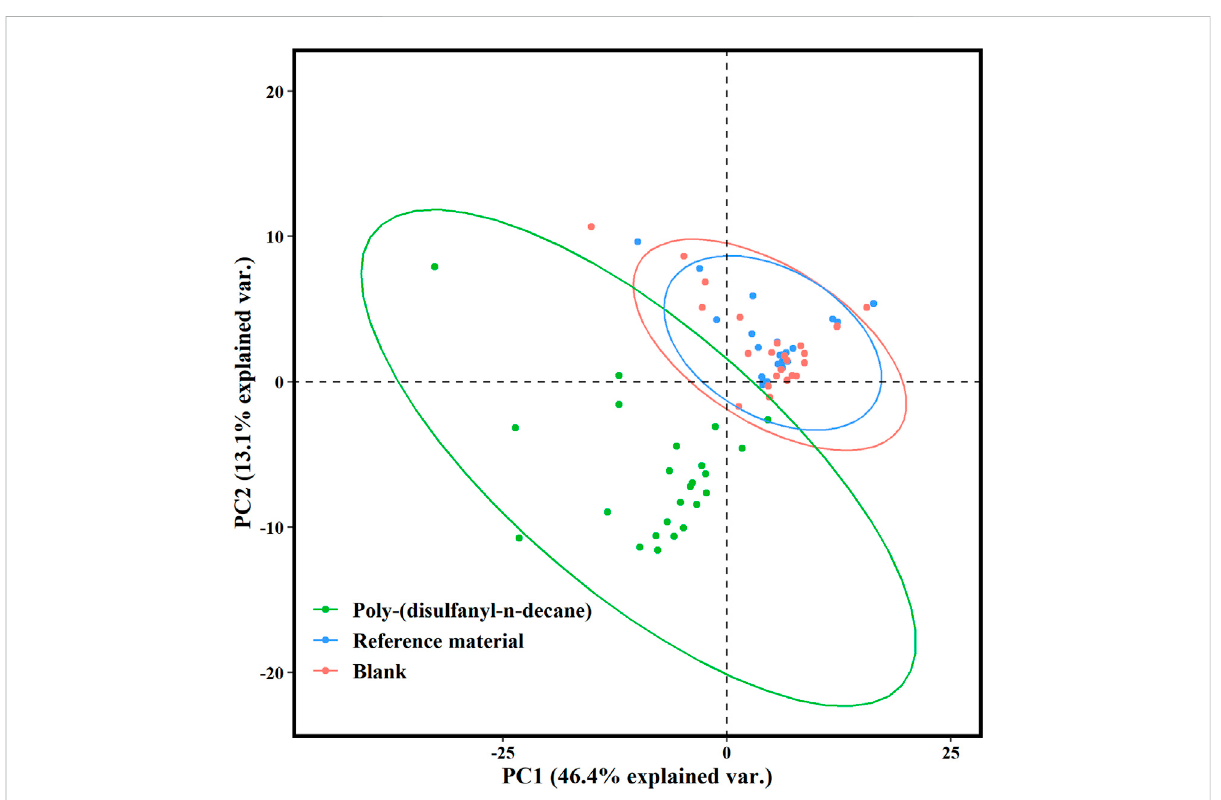
FIGURE 6 The percentage of biodegradation of poly-(disulfanyl-n- decane) and of the reference material.